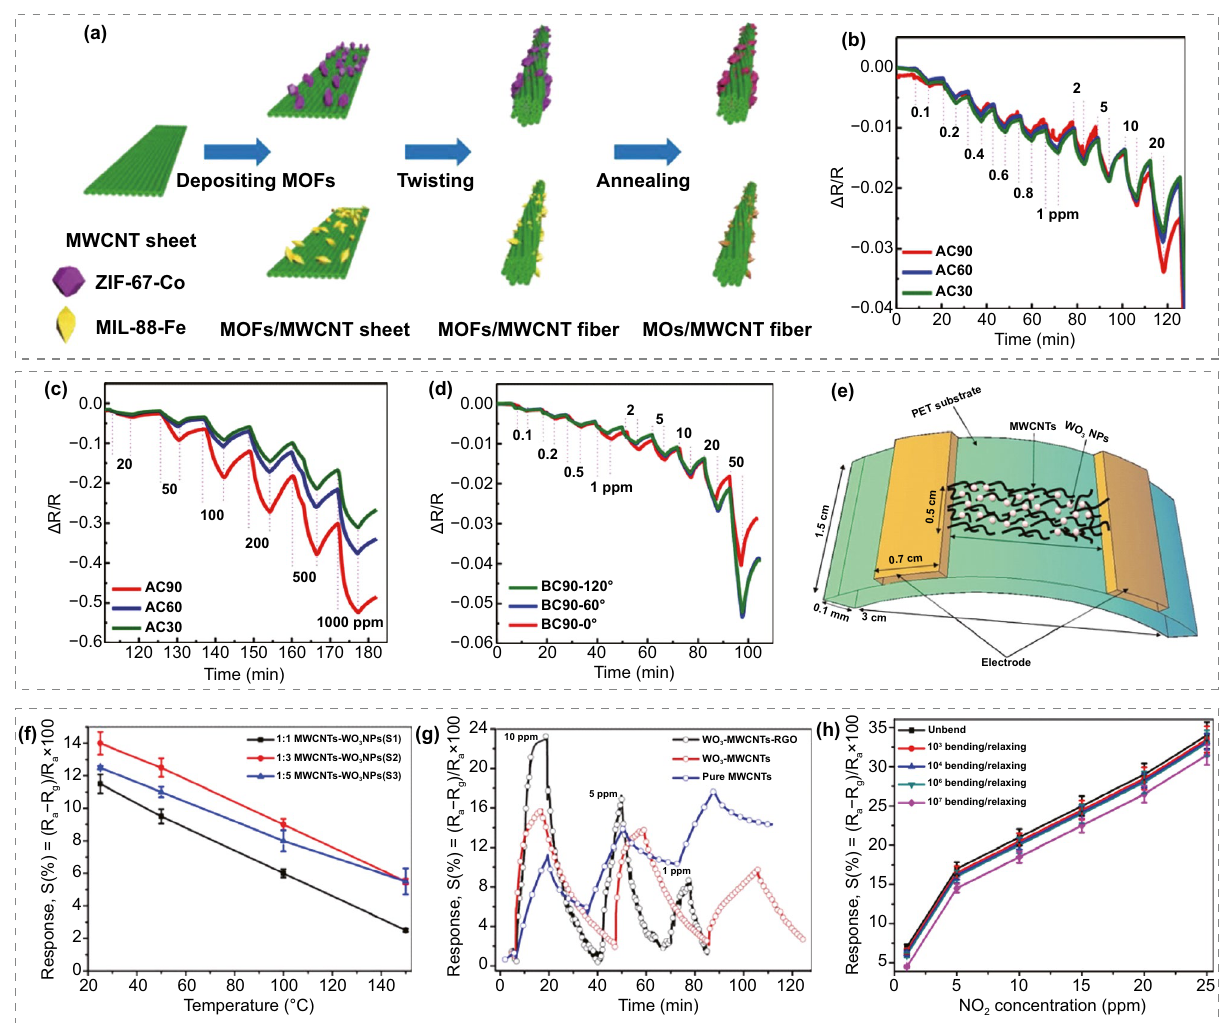
Fig. 6 a The process flow for preparation of MOFs modified MWCNT fibers. Transient response of Co 3 O 4 /MWCNT hybrid fibers to b 0.1– 20 ppm c 20–1000 ppm NO 2 at RT. d Transient response of the Co 3 O 4 /MWCNT hybrid fibers to 0.1–50 ppm NO 2 at 0°, 60°, and 120°. Repro‑ duced with permission from Ref. [64]. Copyright (2018) American Chemical Society. e Schematic diagram of WO 3 /MWCNT‑based sensor. f Response of WO 3 /MWCNT‑based sensor as a function of operating temperature. Reproduced with permission from Ref. [73]. Copyright (2015) Elsevier. g Transient response of pure MWCNTs, WO 3 /MWCNTs and WO 3 /MWCNT/RGO. h Response of WO 3 /MWCNT‑based sensor after different cycles of bending/relaxing tests. Reproduced with permission from Ref. [72]. Copyright (2016)